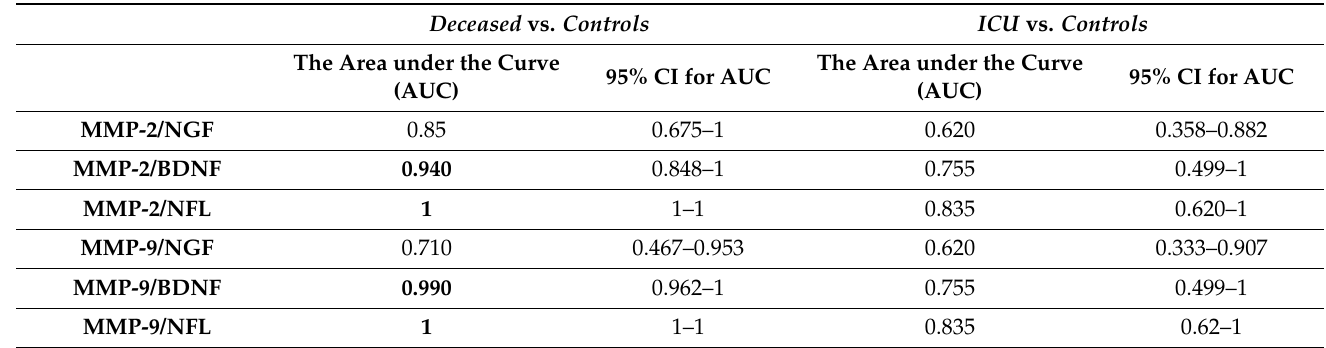
Table 2. AUC scores for the MMP-2/NGF, MMP-2/BDNF, MMP-2/NFL, MMP-9/NGF, MMP- 9/BDNF, and MMP-9/NFL ratios. The highest scores (in bold) were disclosed in the deceased group. Deceased vs.